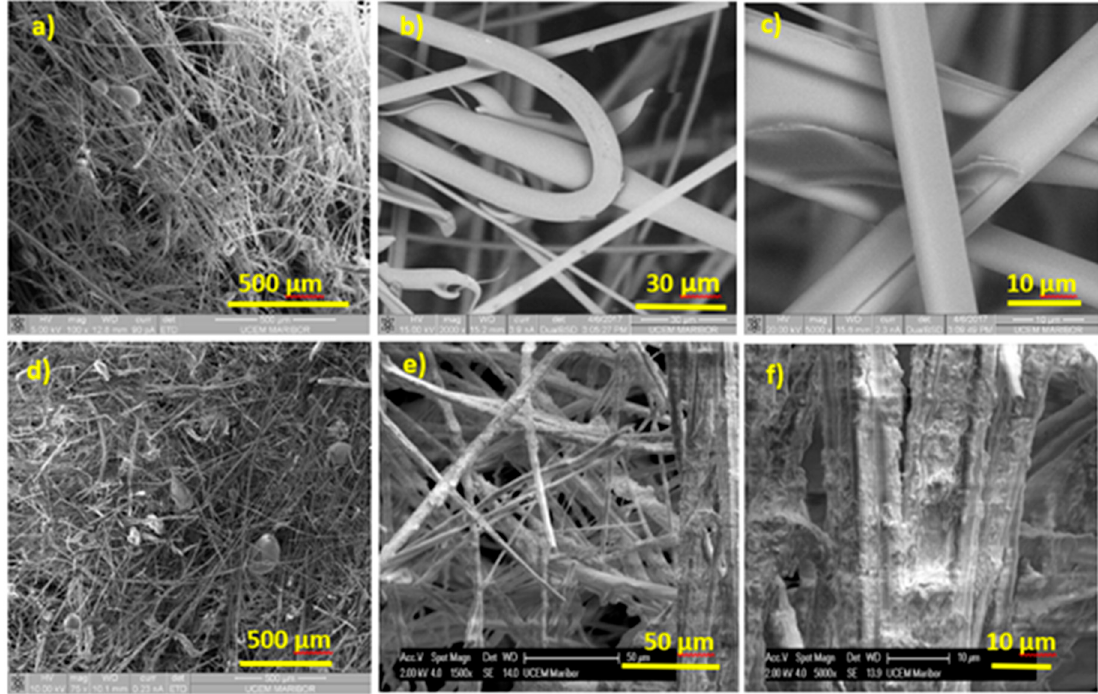
Materials 2020 , 13 , x FOR PEER REVIEW 8 of 12 Figure 6. SEM microanalysis of new ( a – c ) and aged ( d – f ) insulating material.